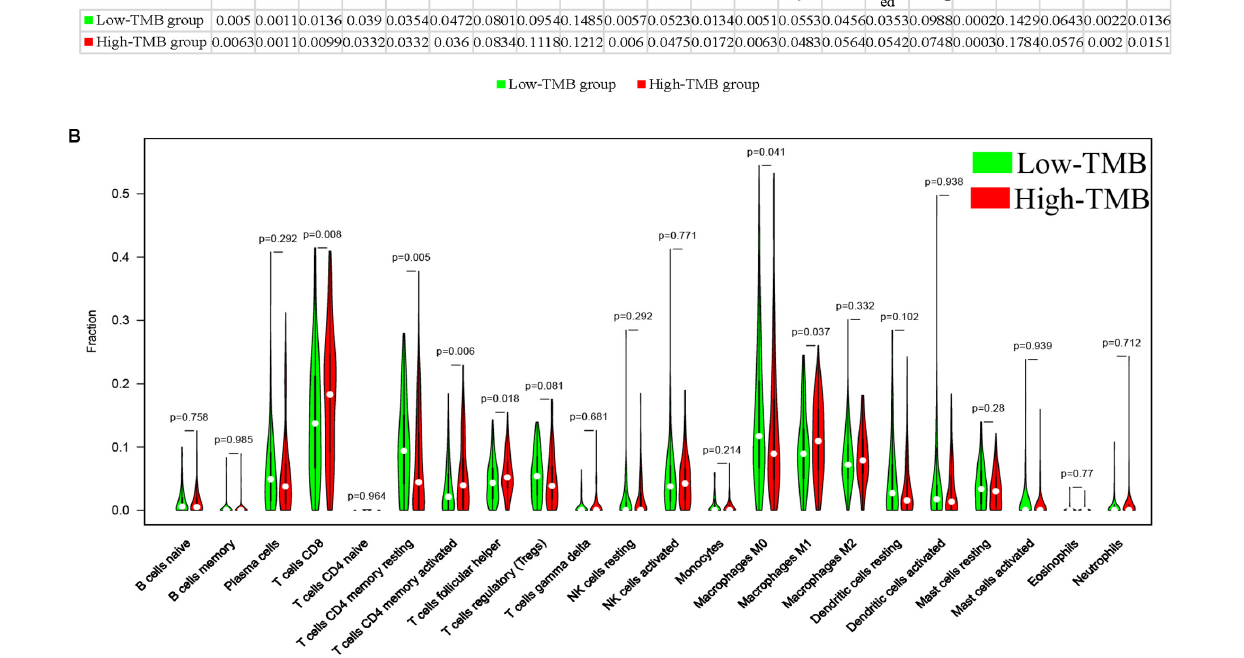
T cells follicular helper, Macrophages M0 and Macrophages M1 ( Figure 6B